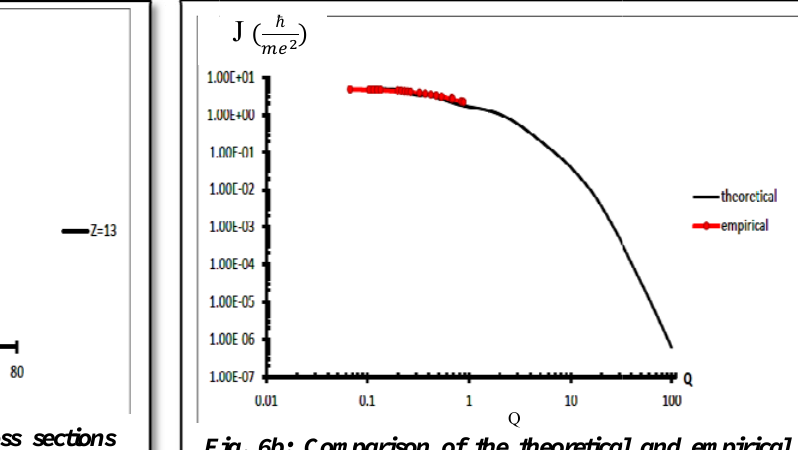
ential cohere nergies at (cid:2242)